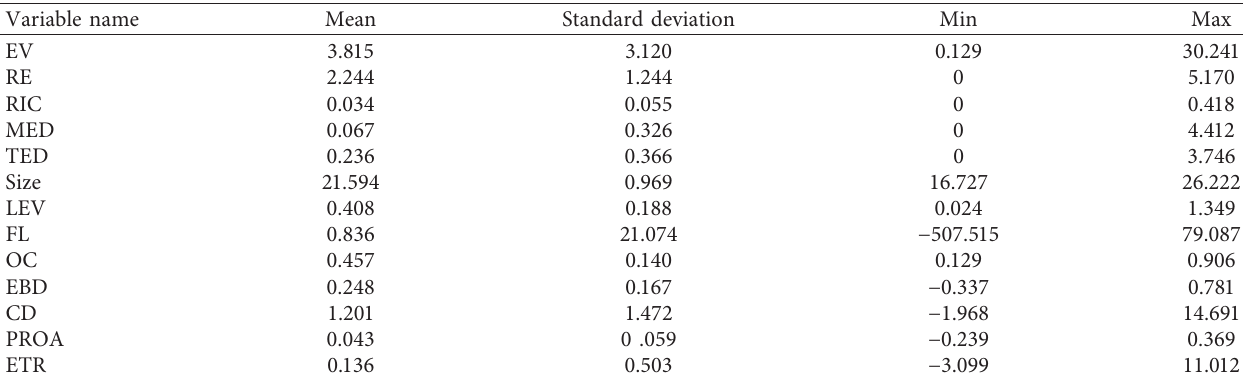
Table 2: Descriptive statistical results of each variable.